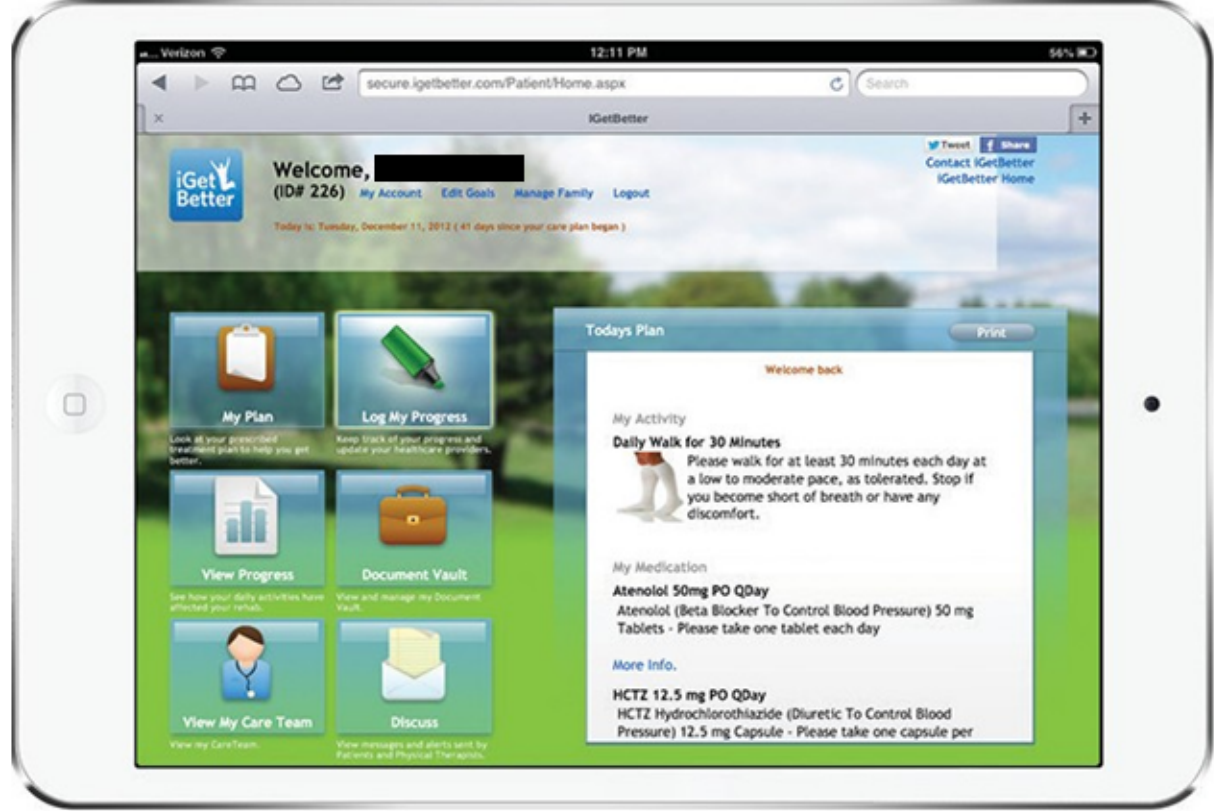
Figure 3. Screenshot of the patient-facing Web portal upon logging